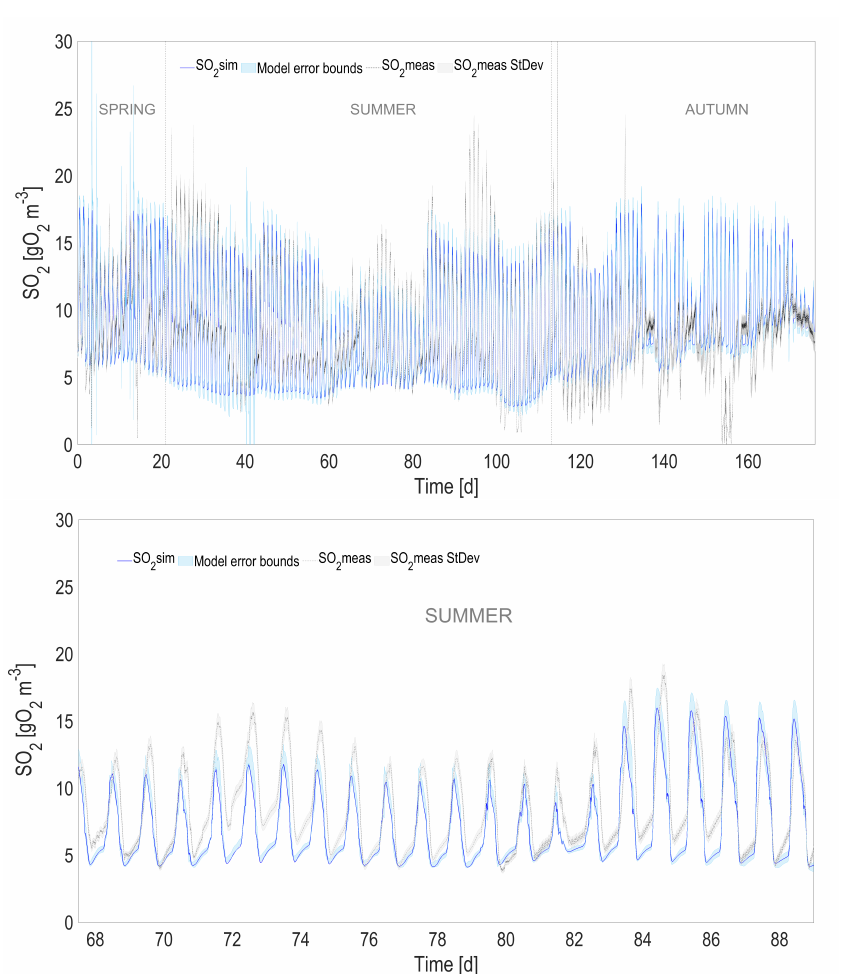
Figure 4. Full prediction capability of the coupled heat transfer and ALBA models for O 2 , compared with simulations using measured temperature (with a zoom in the lower figure). The shaded areas represent the 95% confidence intervals of model predictions.